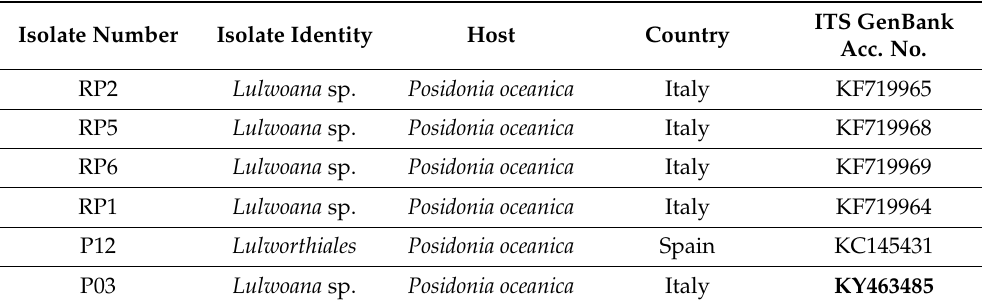
Table 4. Isolates included in this study. The newly generated sequences are indicated in bold font. Isolate